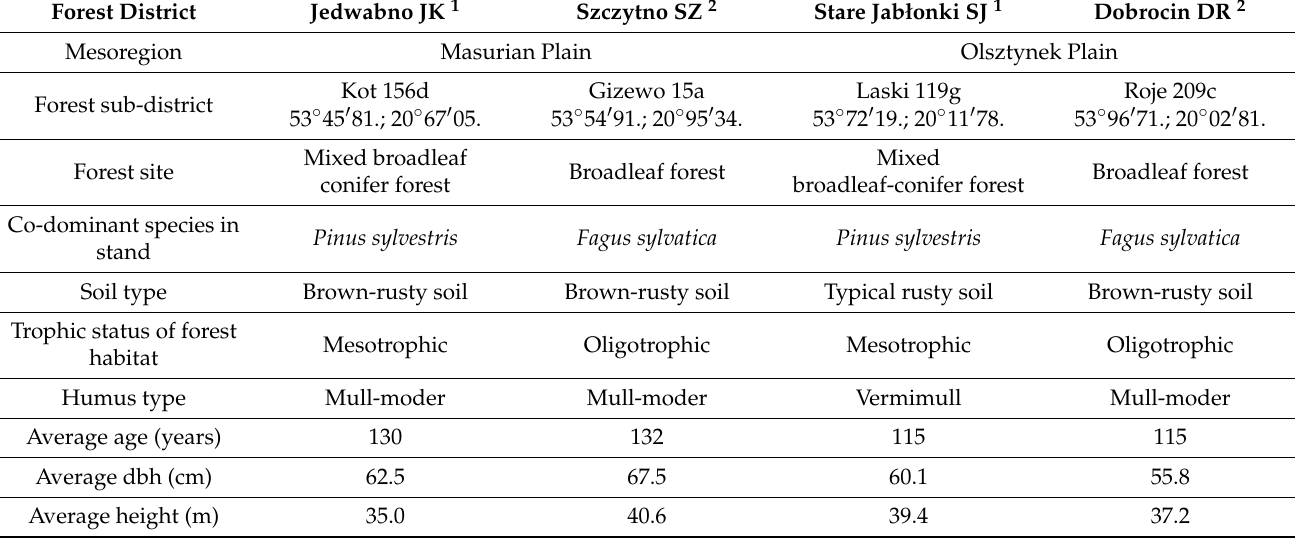
Table 1. Characteristics of investigated areas with Douglas fir on mixed broadleaf-conifer forest site 1 and broadleaf forest site 2 (obtained from the Forest Data Bank and from the authors’